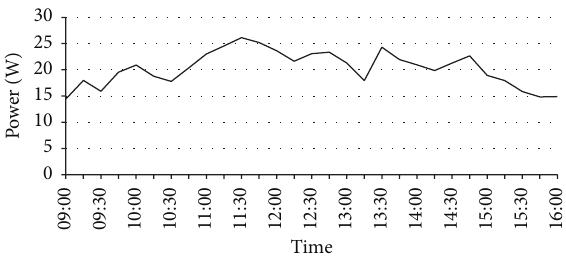
Figure 12: Instantaneous power change during charge of battery.